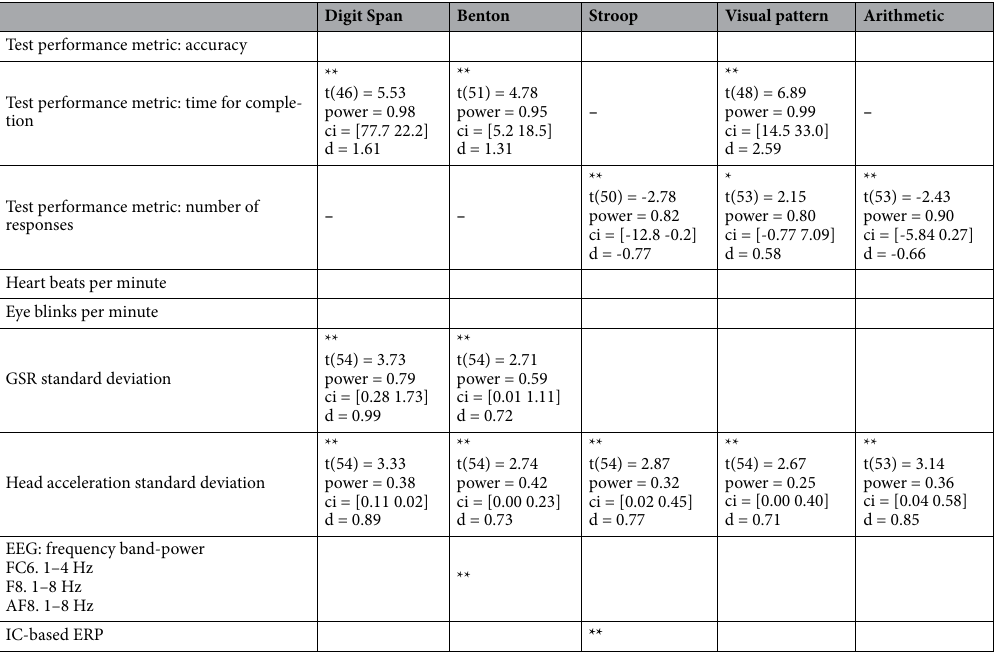
Table 1. Summary of statistical differences between the real-world and VR environments (test performance and physiological responses for all five cognitive tests). Full statistics are reported in-text for the EEG features. The effect sizes for significant differences are reported with the t-statistic and degrees of freedom in parenthesis: a positive number indicates that the metric was higher for the real-world environment. Statistical significance as indicated using the Kruskal–Wallis test: * p < 0.05; ** p < 0.01. Confidence intervals for the corresponding significance threshold: “ci.” Statistical power: “power.” Cohen’s d: “d.” Comparison not available due to experimental design: